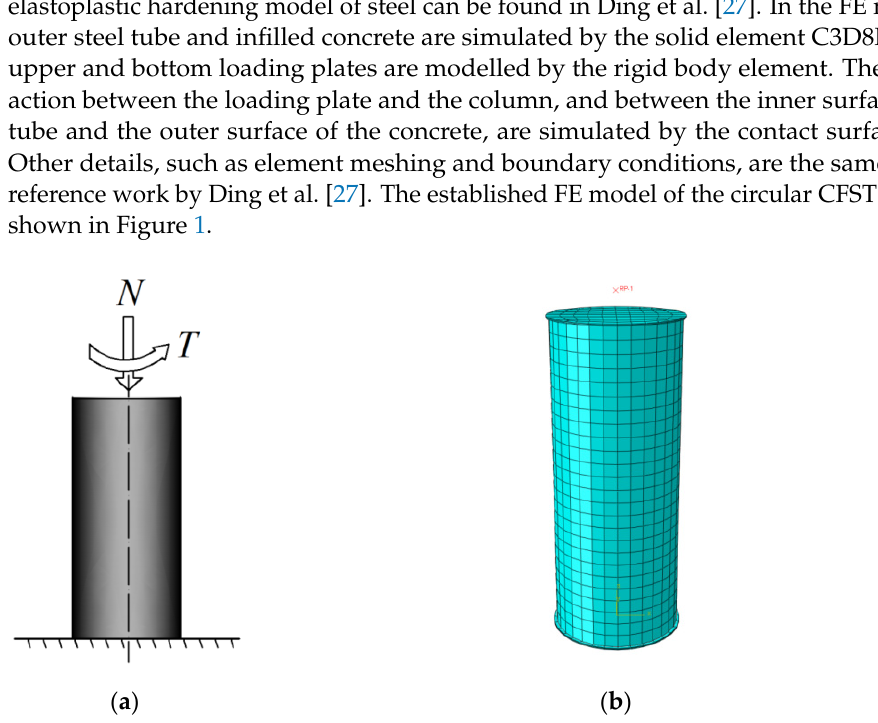
Figure 1. FE model of CFST stub column: ( a ) Loading path of CFST columns; ( b ) mesh result.